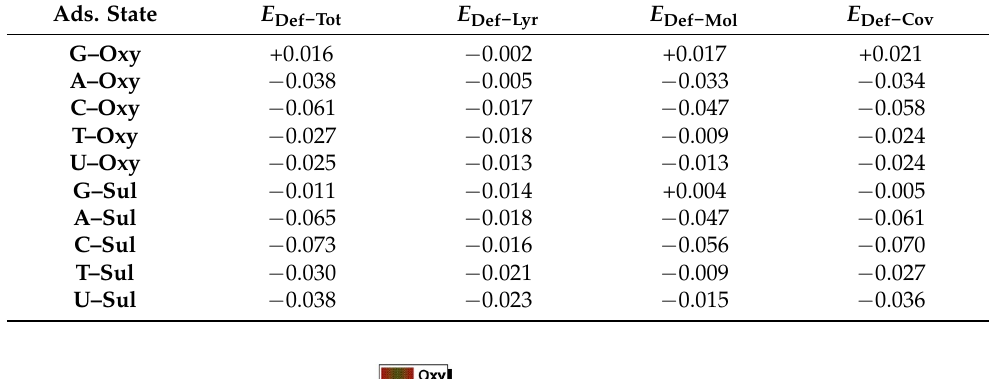
the Gibbs free energies of the adsorption states are also negative for all geometry config- urations, while with a solvent, the adsorption still remains exothermic for the S layer, other than the U case, and could be endothermic by up to 1.5 meV Å − 2 for the O layer, as gap has an important dependency on the binding energy (see Figure S3).